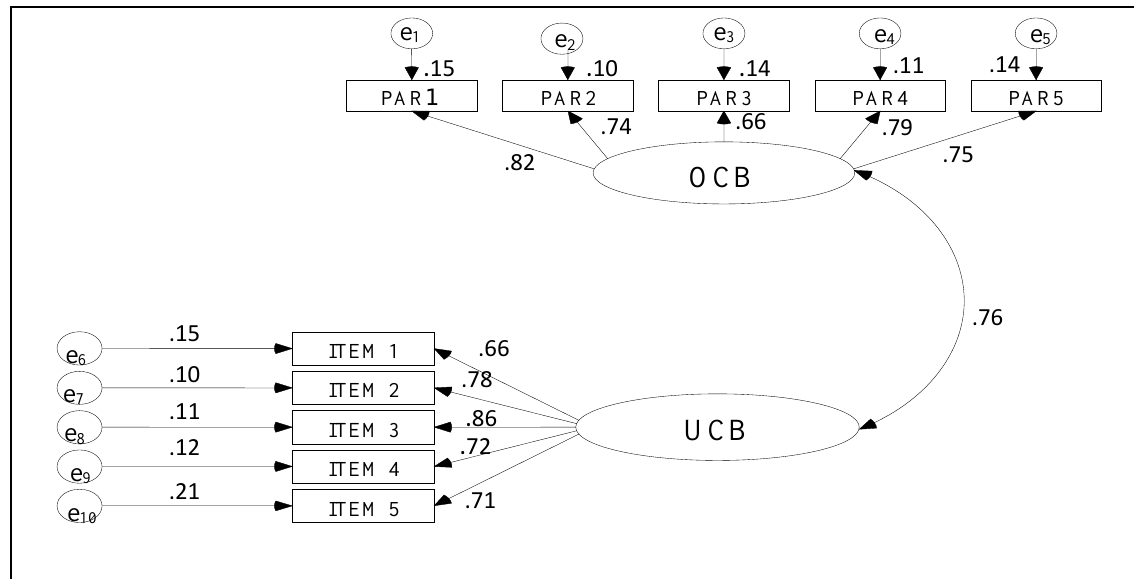
Fig 01: The model for Covariance between OCB and UCB